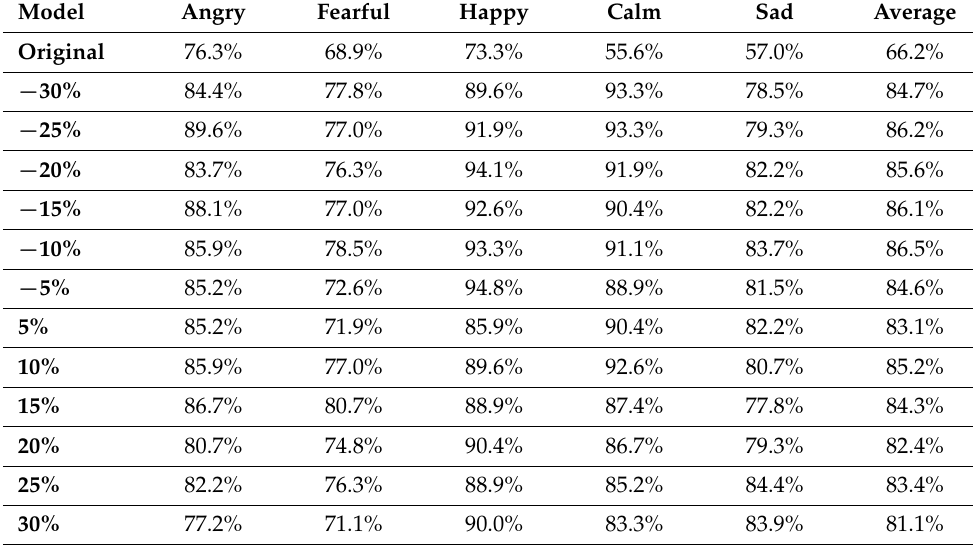
Table 3. Comparison of original method and sound frequency adjustment.